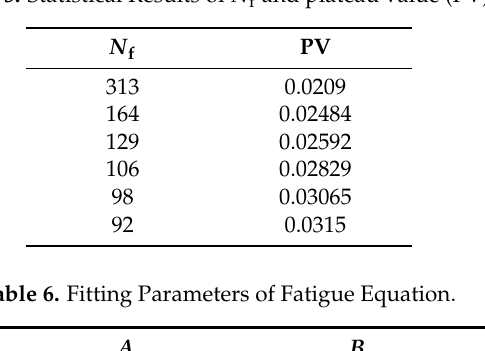
Figure 11. Scatter plots of DSER- N / N f.